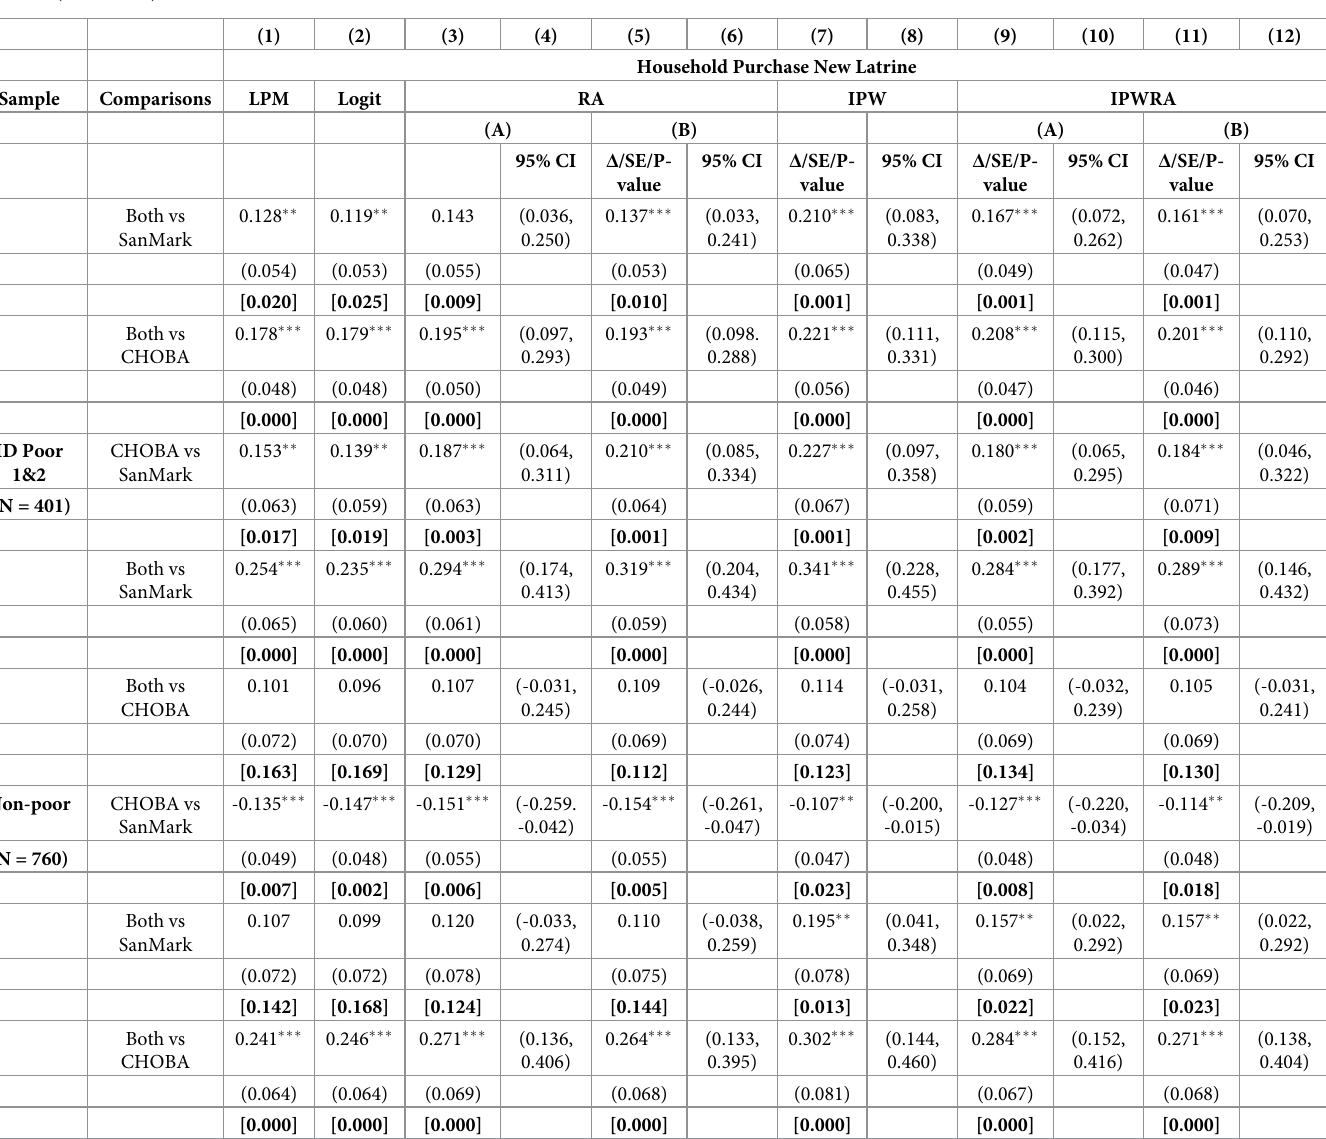
Robust clustered standard errors in parentheses. P-values reported in brackets. 95% confidence interval is reported beside the estimated marginal difference. Sampling weights were applied. Auxiliary regressions for outcome adjustments of RA and IPWRA in (A) were estimated using linear probability model. Auxiliary regressions for outcome adjustments of RA and IPWRA in (B) were estimated using logistic regressions.